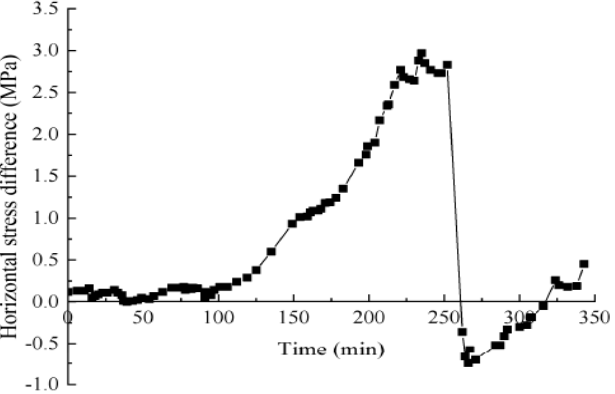
Figure 8. Variation in horizontal stress difference with time in pyrolysis process.